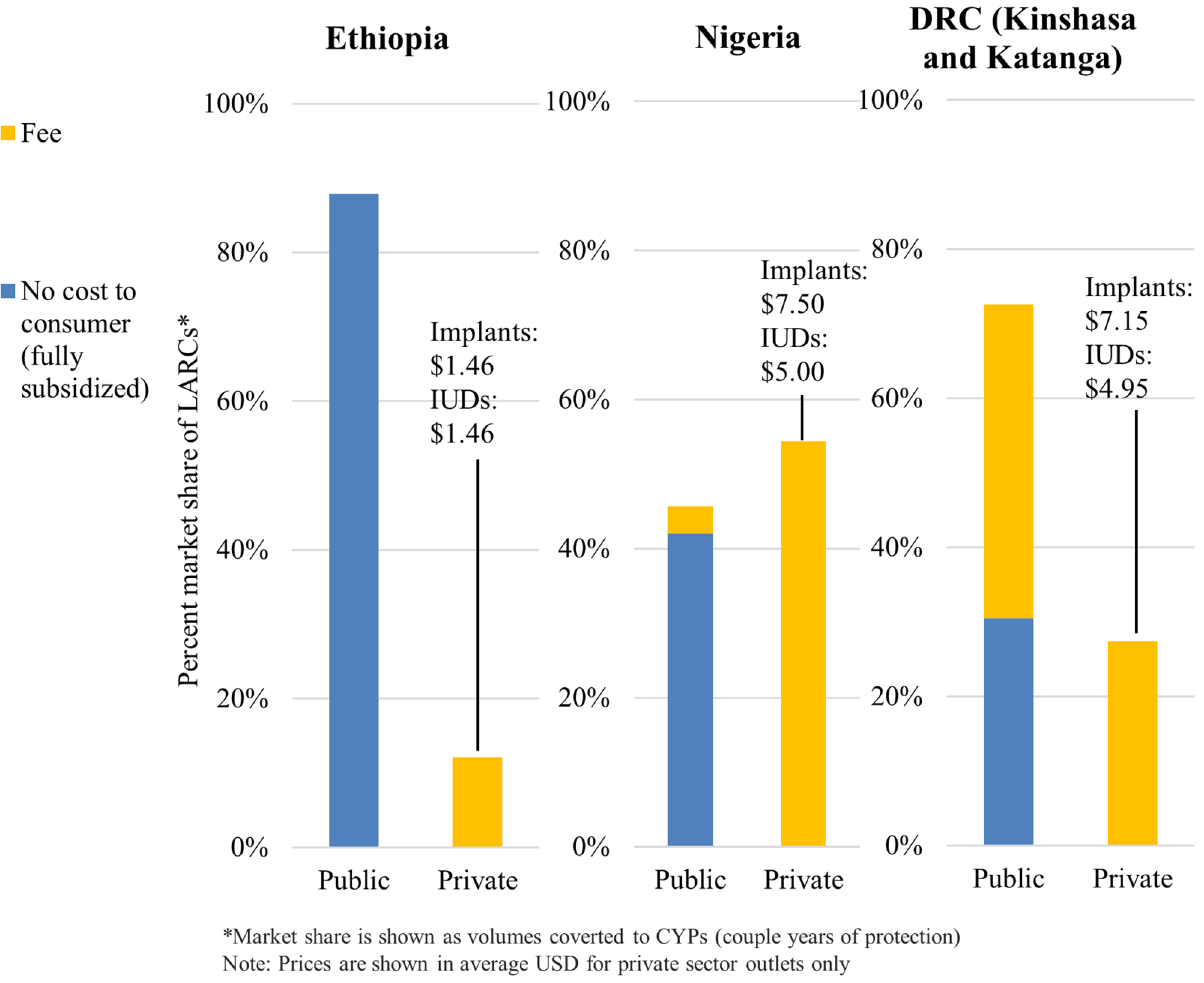
Fig 4. Proportion of LARCs distributed at no cost to the consumer or with a fee by sector and country.